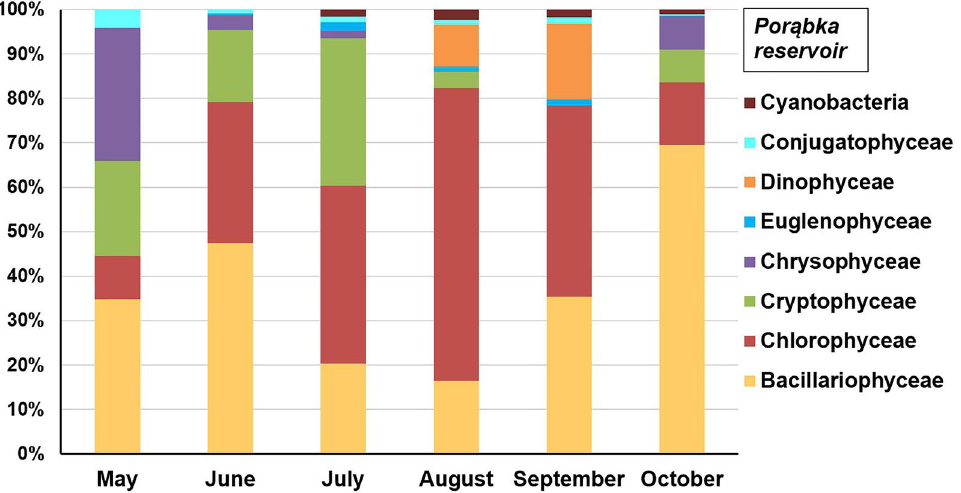
Figure 6. Structure of planktonic algae groups in the Porąbka Reservoir in 2019 year.